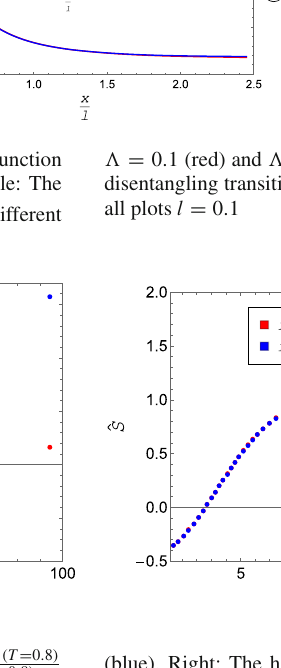
Fig. 3 Left: The relative subregion complexity ˆ C = C ( T ) − C AdS ( T = 0 . 8 ) as a function of (cid:3) for fixed (cid:3) = 0 . 8 and φ M = 10. Different curves T correspond to different subregion length, l = 0 . 1 (red) and l = 0 . 2